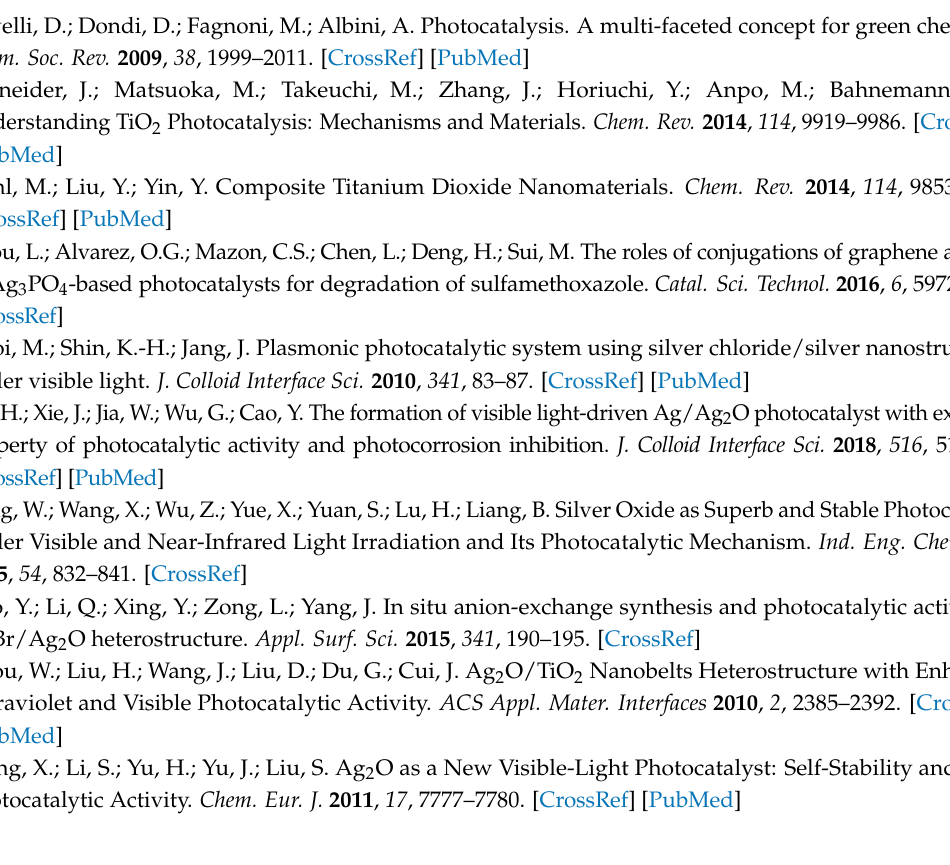
Figure S1: UV-vis spectra of Ag 2 O, Ag@Ag 2 O-G1, Ag@Ag 2 O-G2 and Ag@Ag2O-G3, Table S1: The rate constants and R 2 of first order kinetic reaction for Ag 2 O, Ag@Ag 2 O-G1, Ag@Ag 2 O-G2 and Ag@Ag 2 O-G3 to degrade SMX, Figure S2: XPS spectra of Ag 3d in Ag@Ag 2 O-G2 before and after recycle